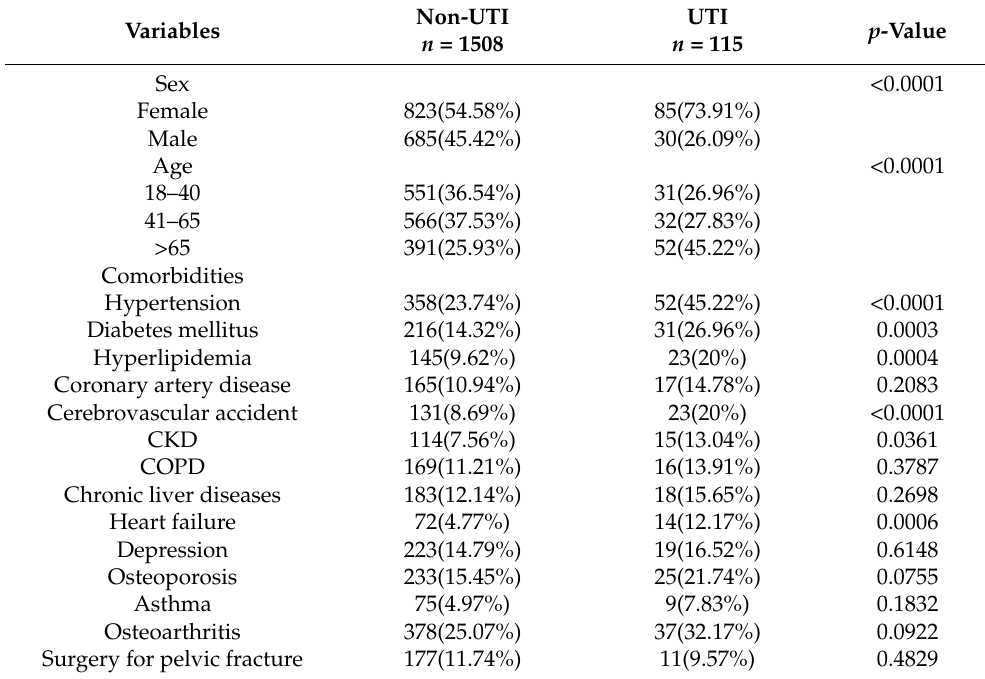
Table 1. Baseline characteristics among study